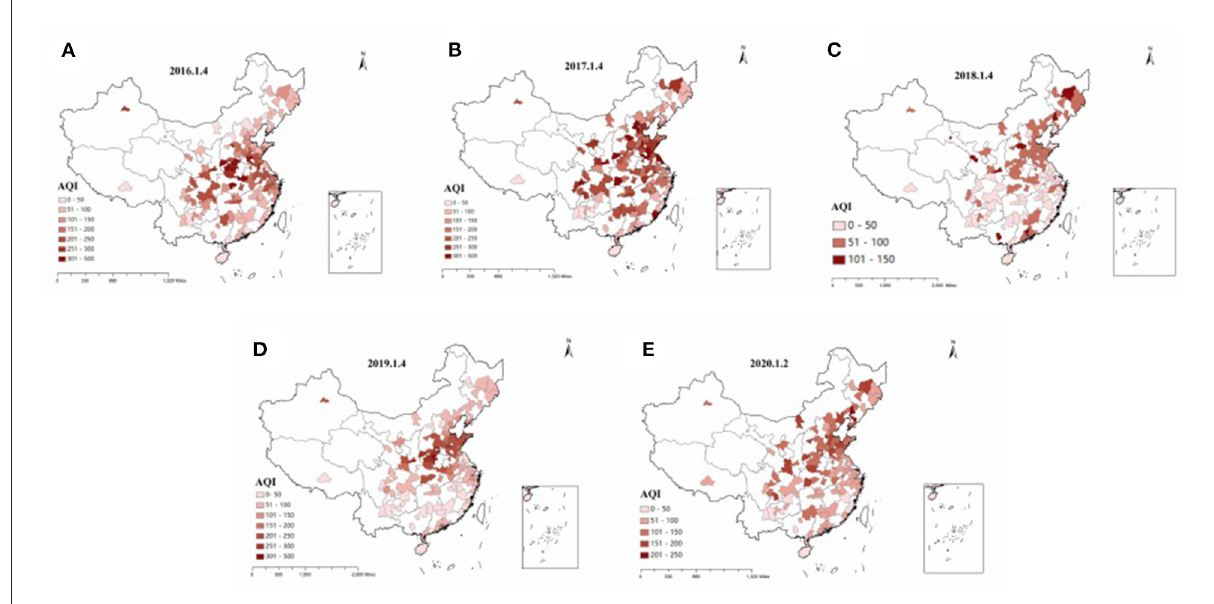
FIGURE4 (A–E) Spatio-temporal evolution of air pollution in different regions of